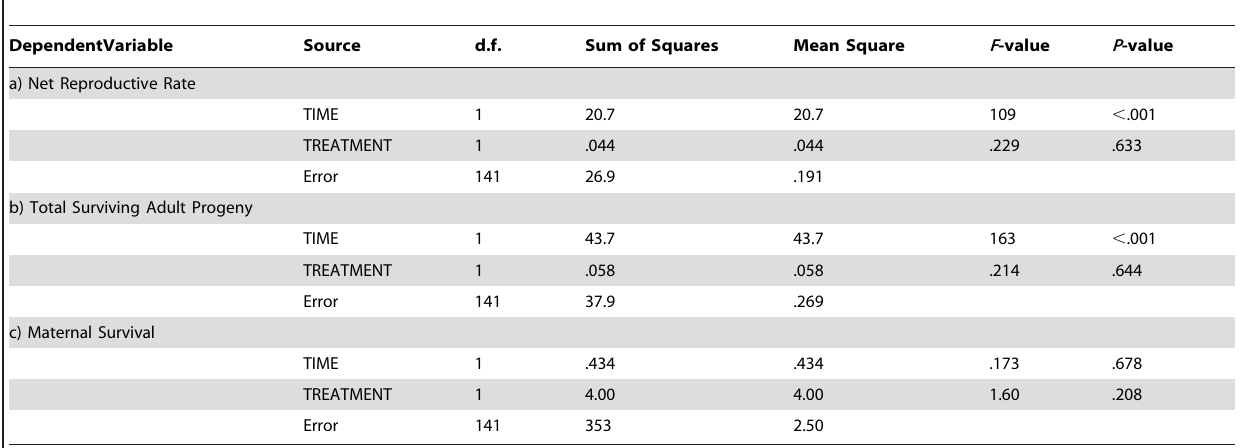
Table 1. Analysis of covariance of treatment and time with respect to net reproductive rate, total surviving adult progeny, and female